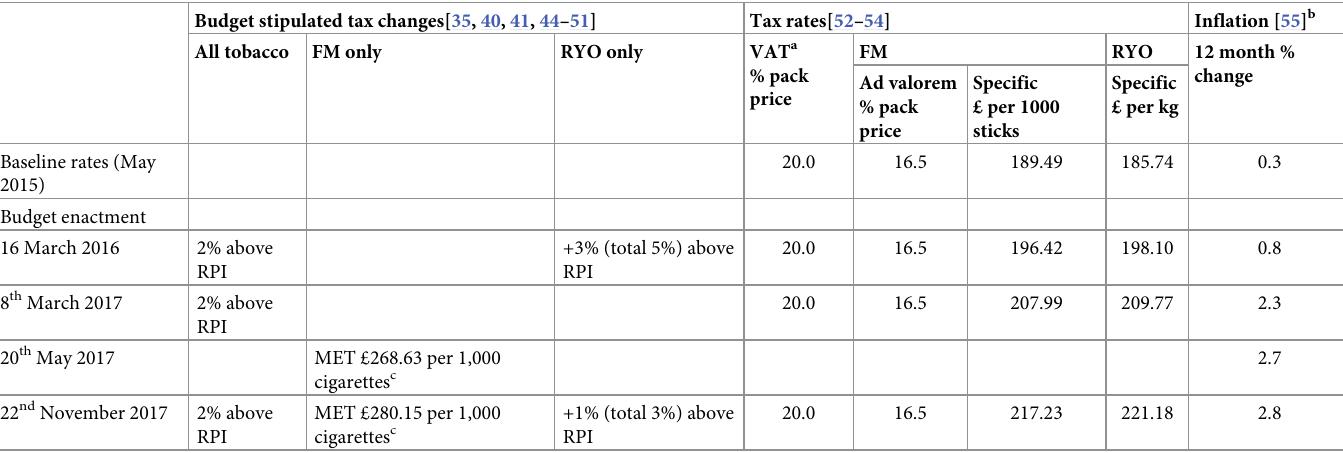
Table 1. Tobacco product (FM and RYO) taxation May 2015 to April